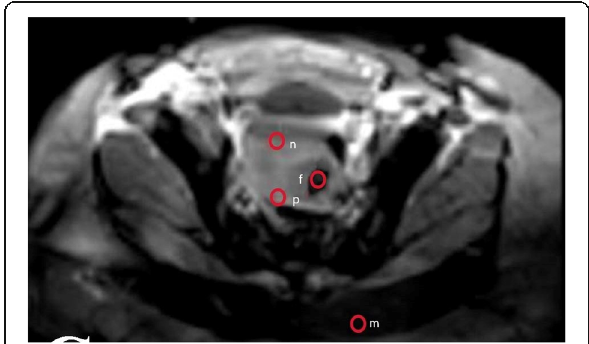
Fig. 1 ROI localization in fibroid patients, in this image the ROIs were put in the myometrium of the posterior wall which possesses the fibroid (positive wall: p), in the anterior wall myometrium that does not possess the fibroid (negative wall: n), in the fibroid itself (f), and in the gluteus maximus muscle